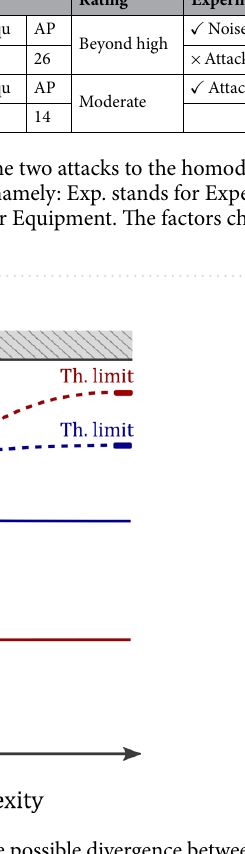
Figure 5. Pictorial representation of the possible divergence between theoretical (th.) and practical (pract.) QKD security. A QKD protocol P1 may have a stronger theoretical security (reachable for a